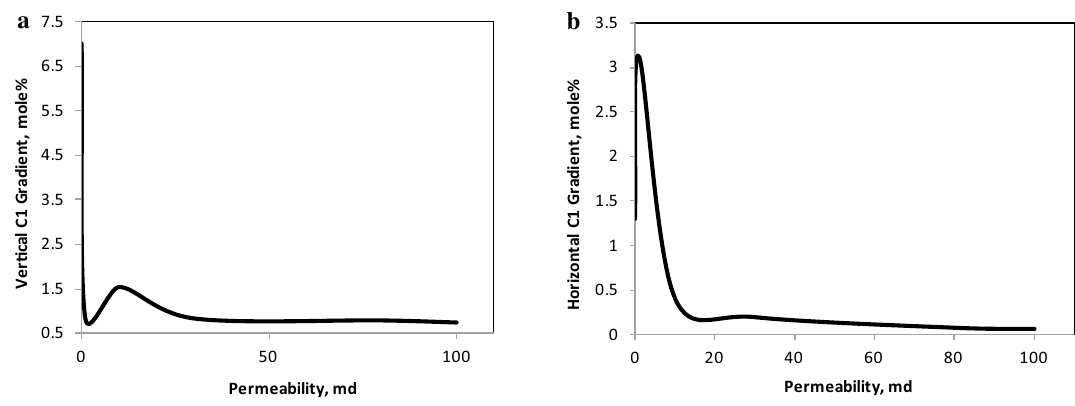
Fig. 8 a Effect of various values of permeability on C tal gradient